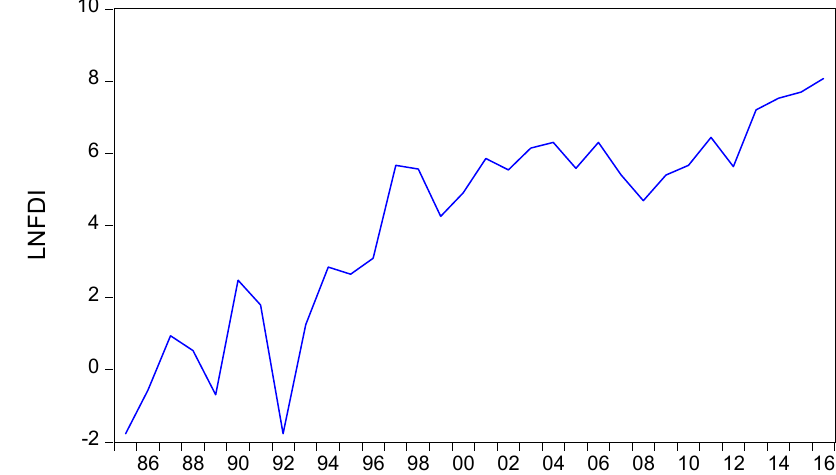
Figure 2. Trends in LnFDI in Ethiopia, 1985–2016.